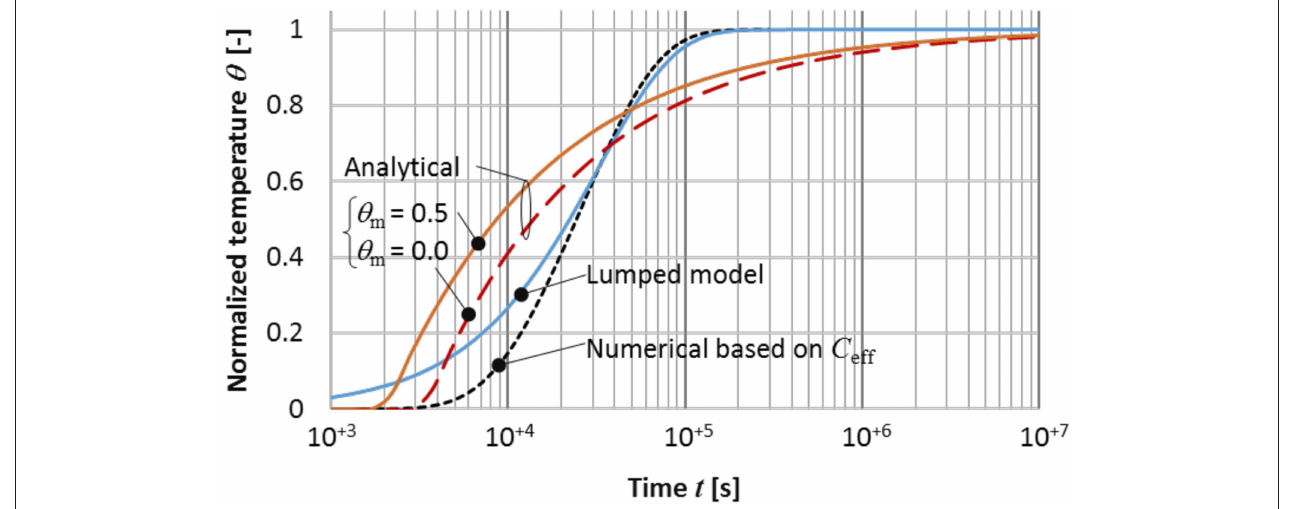
L , t ) to steady state for different models, with L FIGURE 6 | Normalized end wall temperature θ ( x = with a heat of fusion H 2.44 x 10 5 [J/kg]. The lumped (single exponential function) and numerical models use C eff determined by Equations (9–11). For this = example, the normalized true melting temperature range is 0.1. Analytical models are the cases of normalized melting points θ m